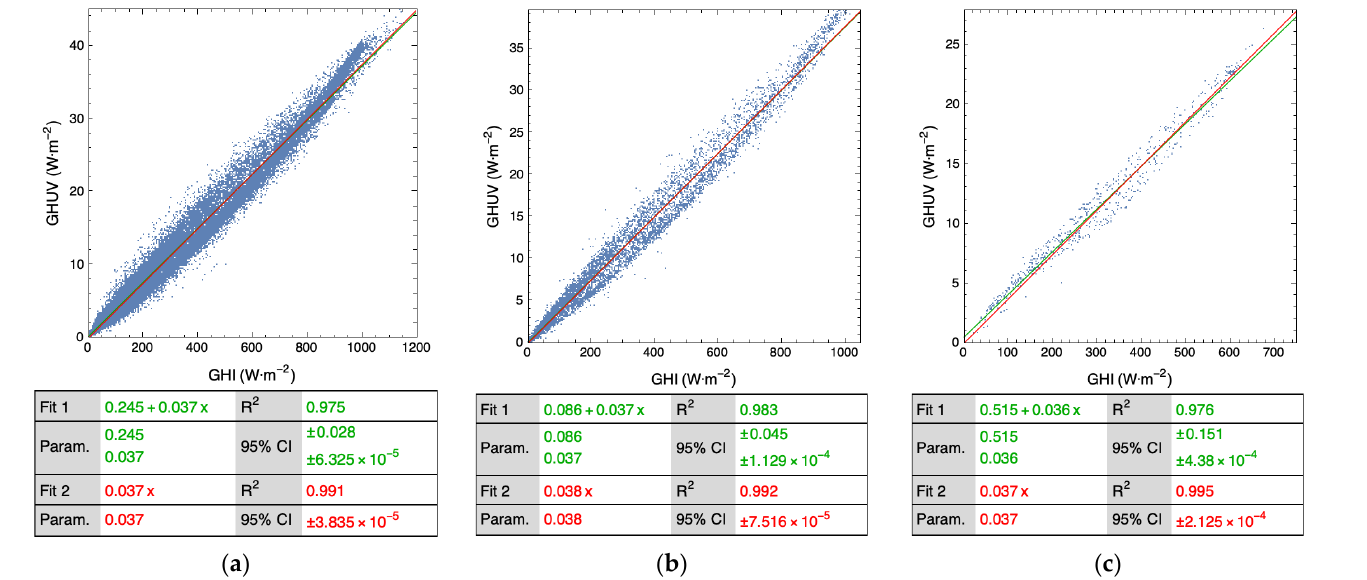
Figure 11. GHUV and GHI (W ∙ m − 2 ) values recorded in Burgos (Spain) from 14 September 2020 to 6 June 2022: ( a ) 10 min data; ( b ) hourly average of 10 min data; ( c ) daily average of 10 min data. Tables below each plot show the two linear regressions (with and without constant), as well as the R 2 value and the 95% confidence interval (CI).